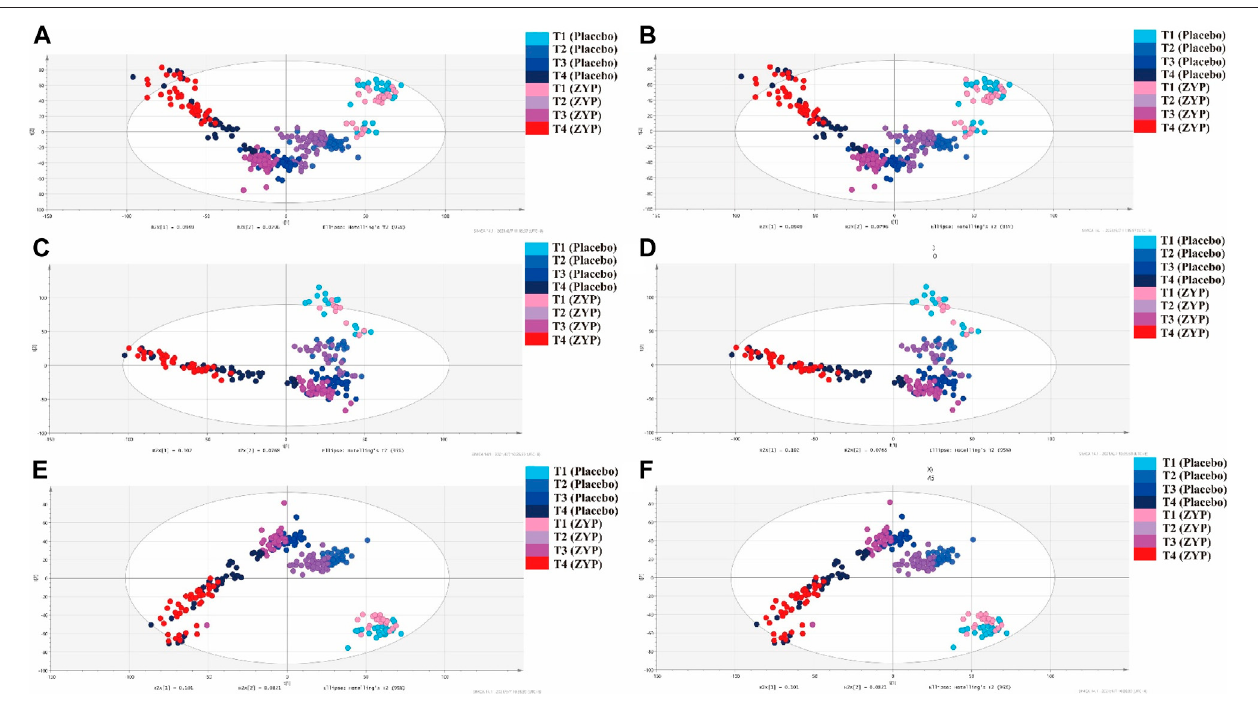
FIGURE2| PCAanalysisonplasmasamplesinwholedatasetandtwosubgroups. (A) PCAanalysisofwholedatasetinpositivemode. (B) PCAanalysisofwholedatasetin negativemode. (C) PCAanalysisofAMAsubgroupinpositivemode. (D) PCAanalysisinAMAsubgroupinnegativemode. (E) PCAanalysisinAHsubgroupinpositivemode. (F) PCA analysis in AH subgroup in negative mode. : T1 (Placebo), : T2 (Placebo), : T3 (Placebo), : T4 (Placebo), : T1 (ZYP), : T2 (ZYP), : T3 (ZYP), : T4 (ZYP).